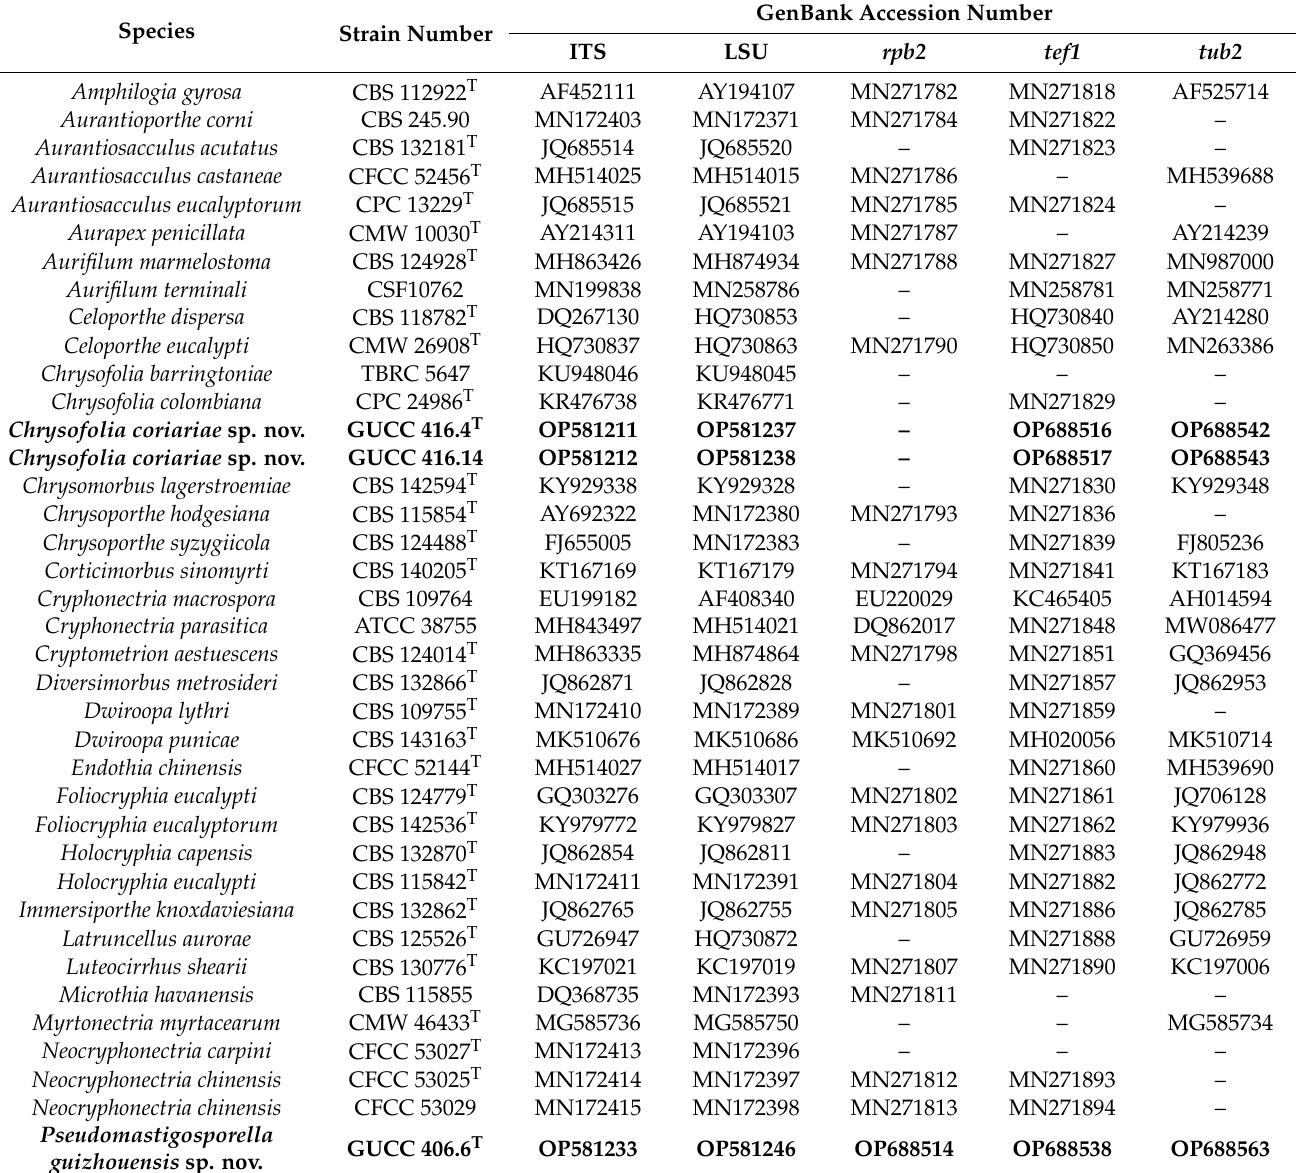
Table 2. Strains and their GenBank accession numbers used in the molecular phylogenetic analyses of Cryphonectriaceae and Foliocryphiaceae . Newly generated sequences are in bold. ( T ) = ex–type